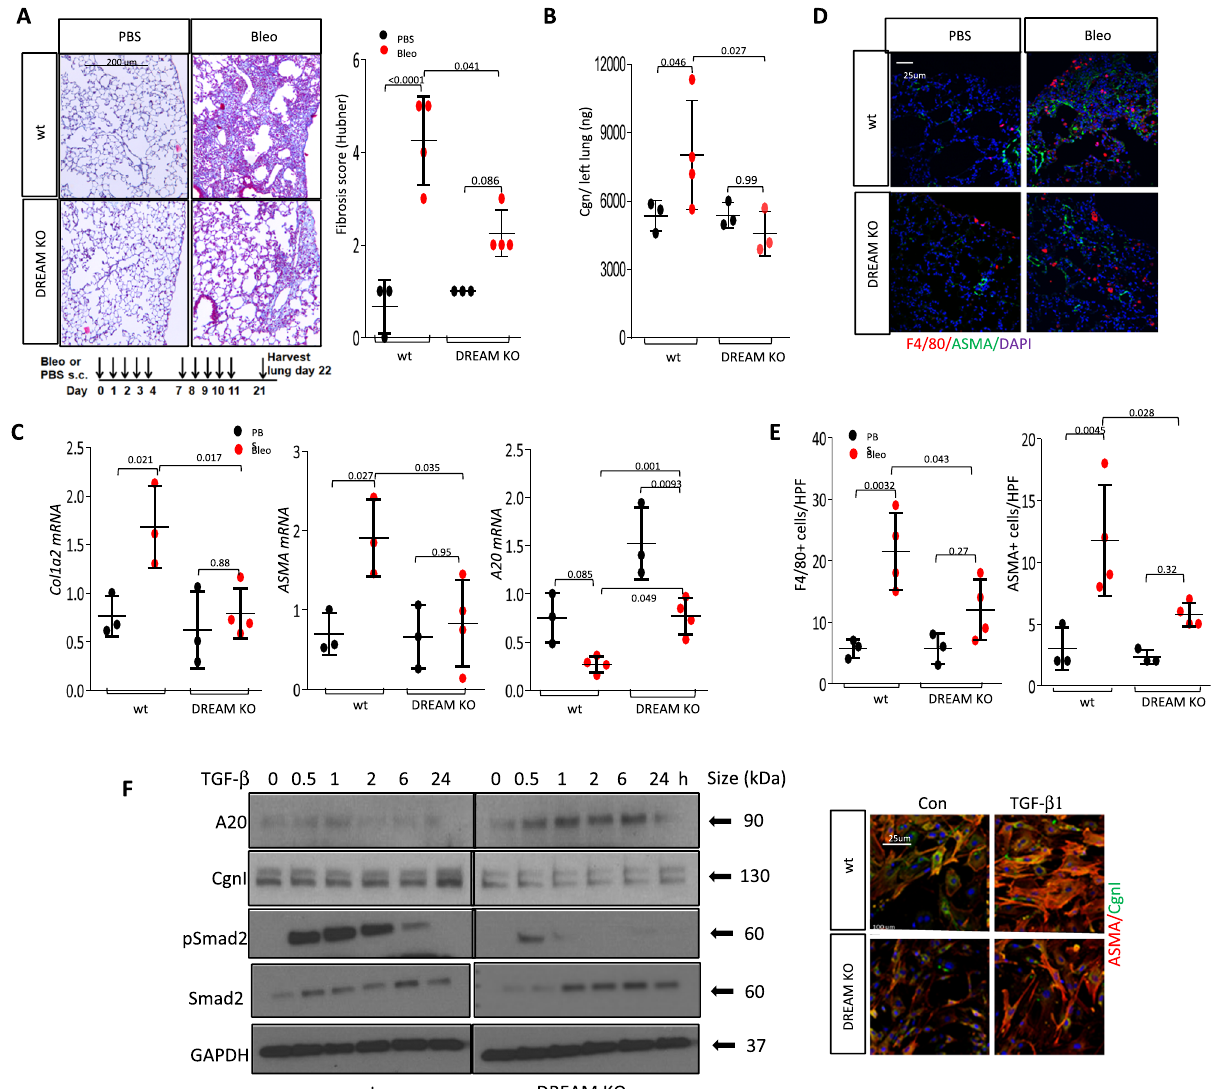
Fig. 7 | DREAM -/- mice showed attenuated lung fi brosis. Eight-week-old C57/BL6 wild-type mice and DREAM -/- mice in parallel were administered s.c. bleomycin or PBS for 2 weeks (5 days/week) and lungs were harvested on day 22. A Bottom: schematic representation of the experiment. Left panels: trichrome stain. Repre- sentative images; size bars=200 µ m. Right panel: lung fi brosis (Hubner score) in 8 hpf/mice. Results are mean±SD from 4 mice (Bleo-treated) and 3 mice (PBS-trea- ted) per group. One-way ANOVA followed by Sidak ’ s multiple comparison test. B Collagencontent.Resultsrepresentthemean±SDfrom3(PBS-treated)or4mice (Bleo-treated)pergroup.One-wayANOVAfollowedbySidak ’ smultiplecomparison test. C qPCR. Results, normalized with GAPDH, are mean±SD of triplicate deter- minations from 3 (PBS-treated) or 4 mice (Bleo-treated) per group. One-way